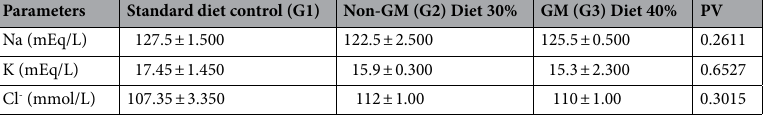
Table 3. Serum electrolytes.